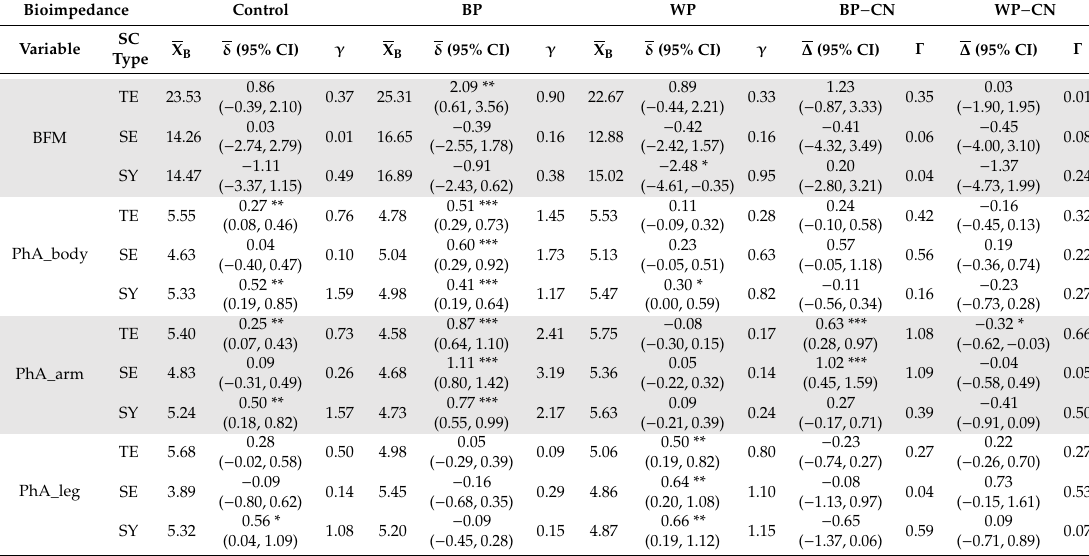
Table A2. Changes in bioimpedance variables after FTPs according to SC types (ANCOVA results). The details are identical to those in Table